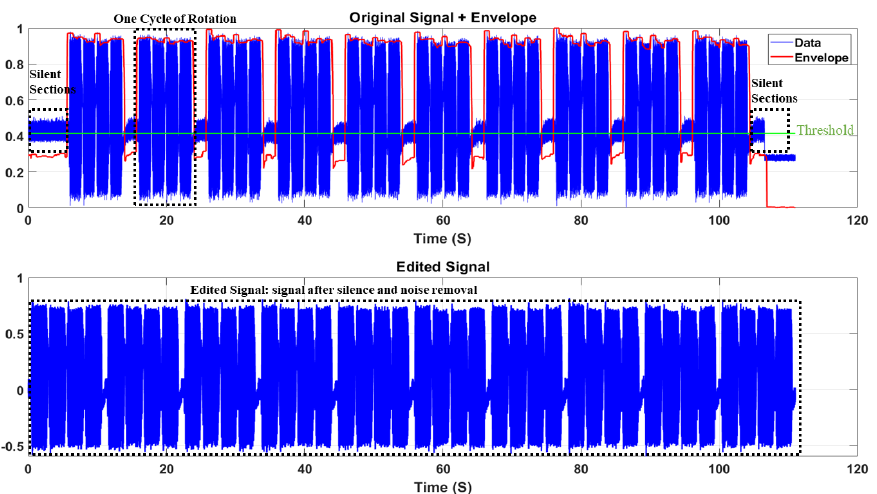
Figure 11. An example of the raw recorded current signal for Robostar at 10% the speed of rotation.